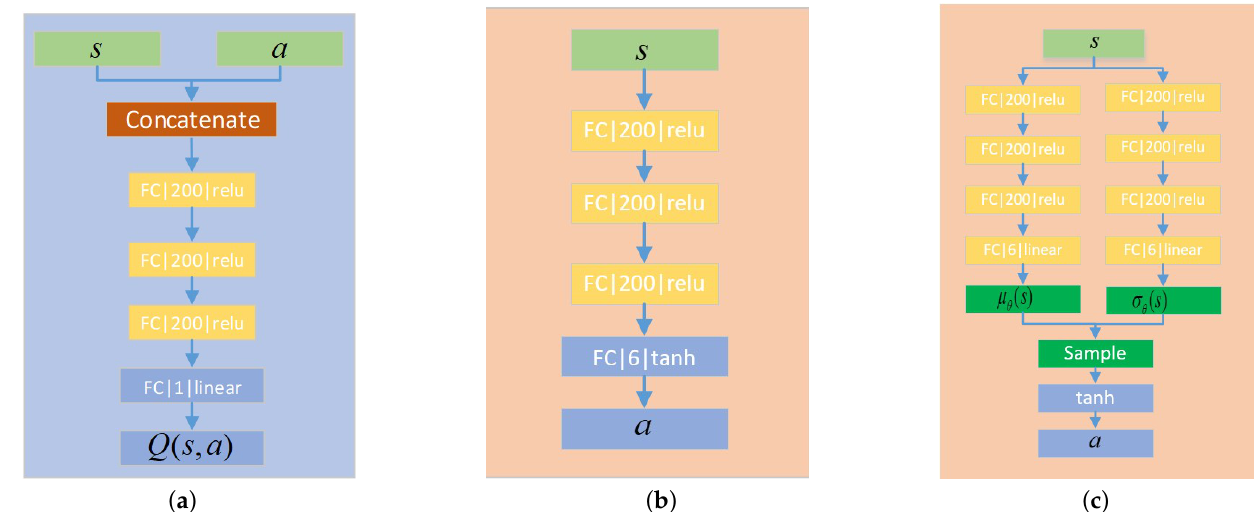
Figure 4. Network architecture. ( a ) Value function network. ( b ) Policy network of DDPG and TD3. ( c ) Policy network of SAC.